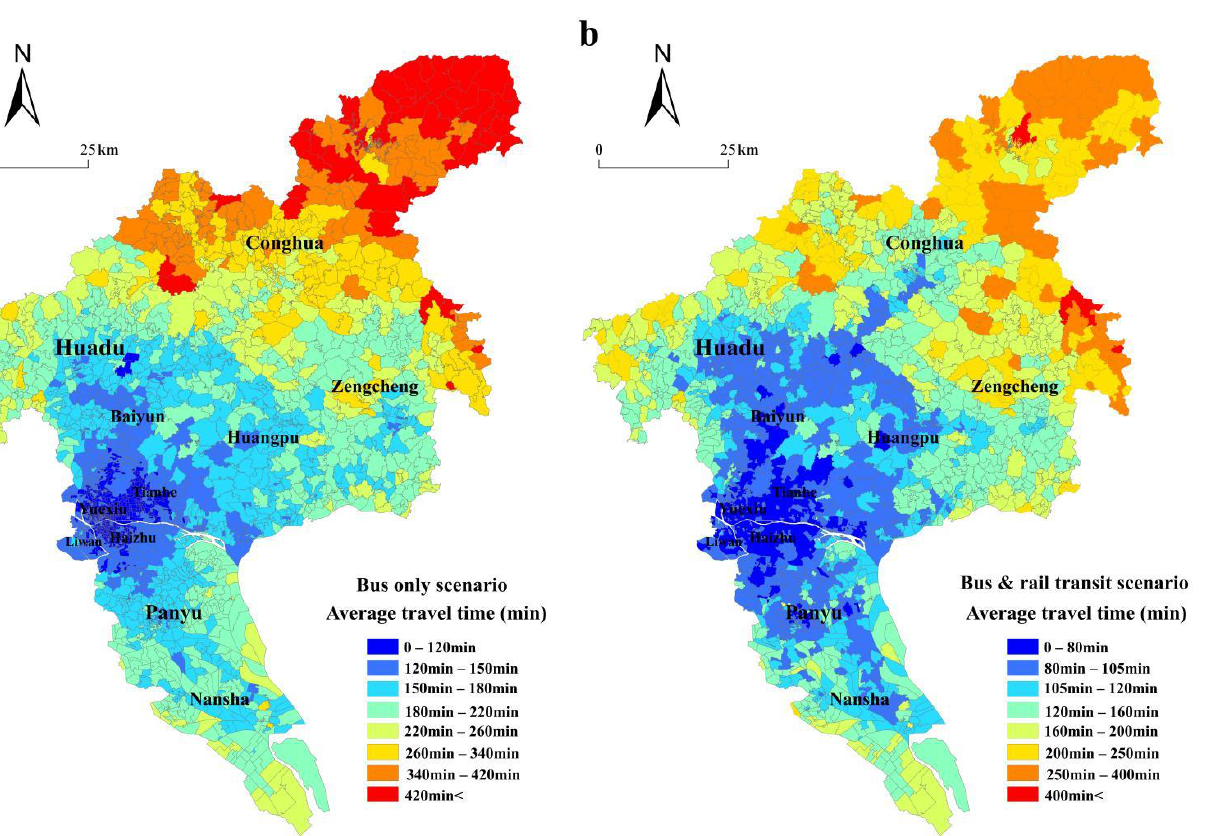
Figure 3. The spatial distribution of time-based accessibility of the CBD in the bus-only scenario ( a ), in bus and rail transit scenario ( b ), and the average travel speed ratio between the two scenarios ( c ).